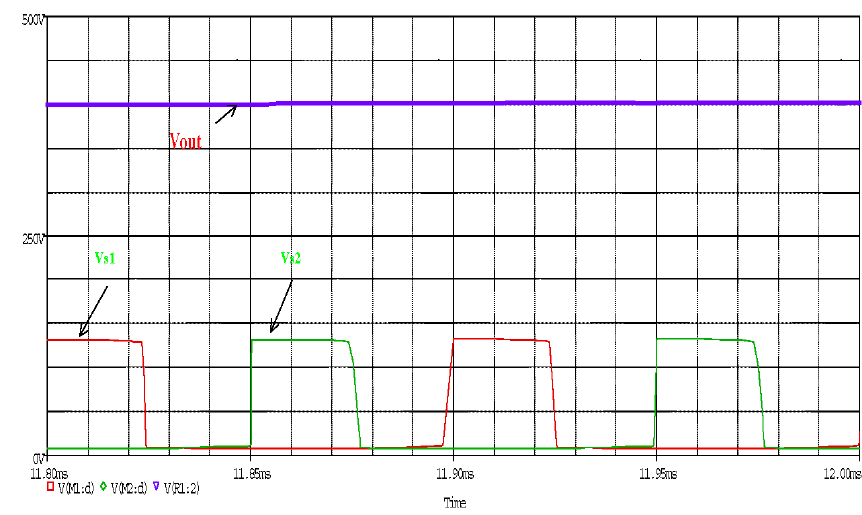
Figure 14. Output voltage waveform across load and voltages across switches.